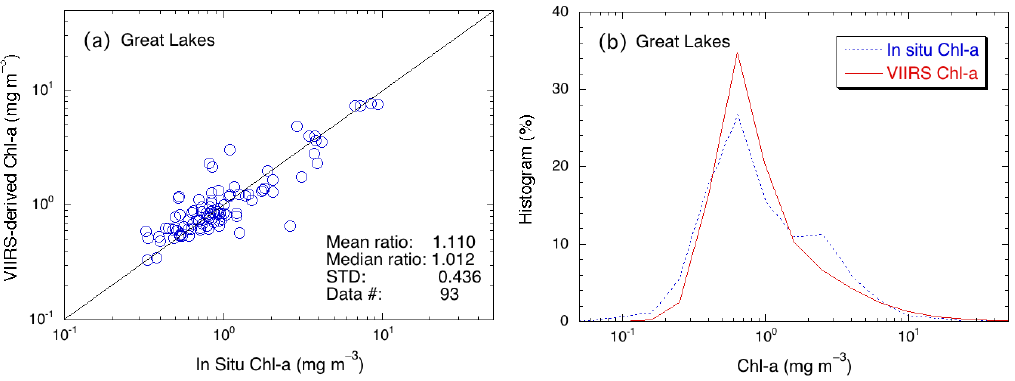
Figure 4. ( a ) Matchup comparison of VIIRS-SNPP-derived Chl-a data (2012–2019) using the proposed Chl-a algorithm (Equation (1)) with the in-situ Chl-a data, and ( b ) histogram results of VIIRS-derived (red line) and in-situ-measured (blue dotted line) Chl-a data.